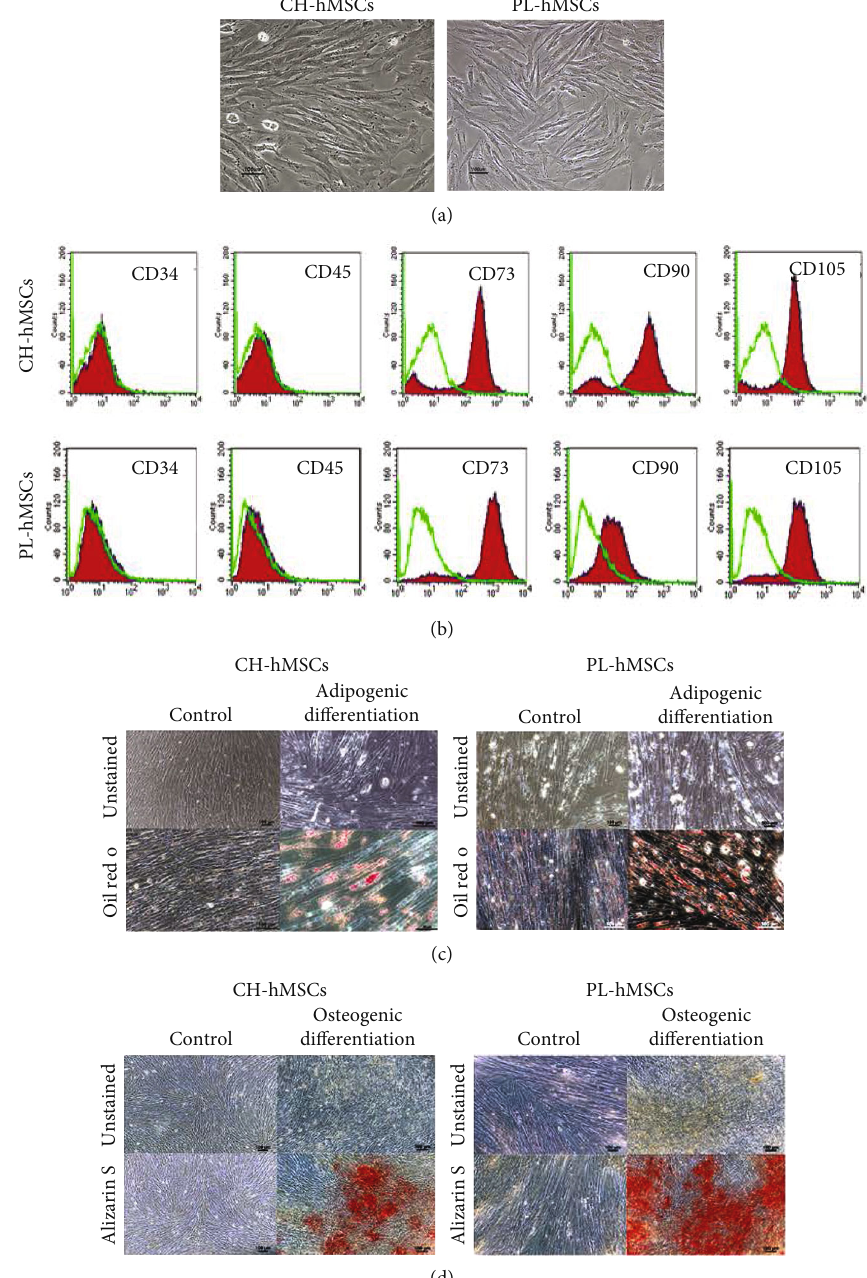
Figure 1: Characteristics of CH-hMSCs and PL-hMSCs. (a) Fibroblast-like morphology of CH-hMSCs and PL-hMSCs (scale bar: 100 μ m). (b) Immunophenotypes of CH-hMSCs and PL-hMSCs as determined by fl ow cytometry. (c) Adipogenic di ff erentiation of CH-hMSCs and PL-hMSCs as determined by oil red O staining (scale bar: 100 μ m). (d) Osteogenic di ff erentiation of CH-hMSCs and PL-hMSCs as determined by alizarin red S staining (scale bar: 100 μ